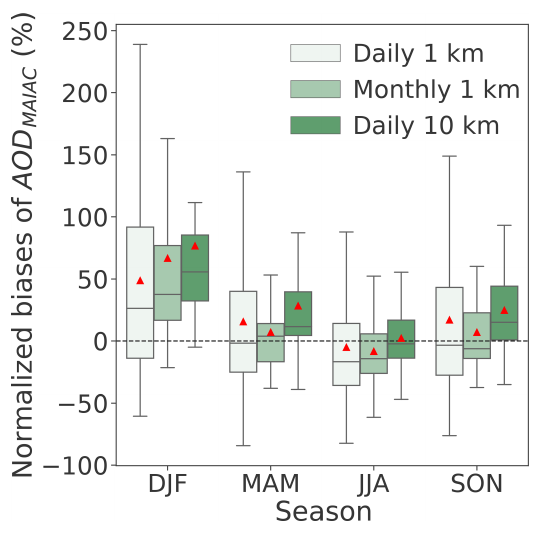
Figure 3. Distribution of normalized biases of AOD MAIAC eval- uated at 52 AERONET (including DRAGON, only available for JJA) sites in four seasons of 2011 over the northeastern US us- ing daily MAIAC AOD at 1km resolution and 10km resolution and monthly average MAIAC AOD composite (only including days when both satellite and AERONET measurements are available) at 1km resolution. The box shows the interquartile range (IQR) while the whiskers extend to show the rest of the distribution with outliers (points that are either 1.5 × IQR or more above the third quantile or below the first quantile) removed. The red triangles show the sea- sonal mean normalized biases. Note that the normalized bias is an asymmetric metric, for which model overestimates are unbounded, whereas model underestimates are bounded by − 100%; therefore the mean of normalized biases is typically higher than the median of the normalized biases.